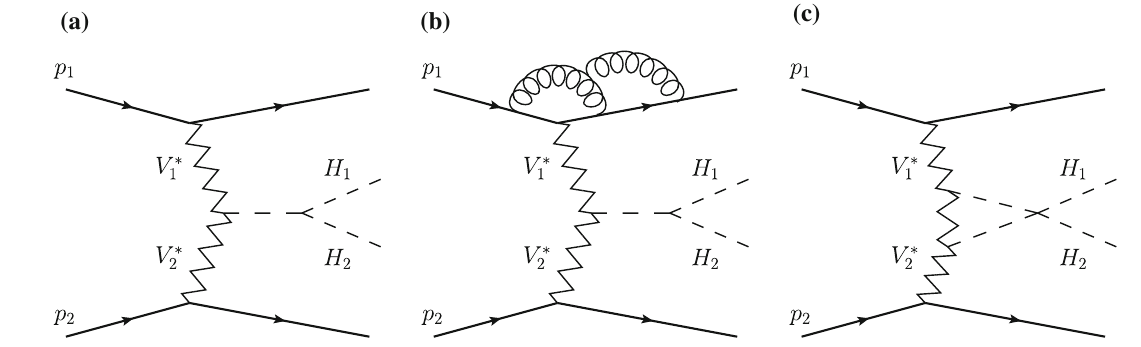
Fig. 1 Examples of Feynman diagrams contributing to the VBF Higgs pair production process at LO ( a ), NNLO QCD ( b ) and NLO EW ( c